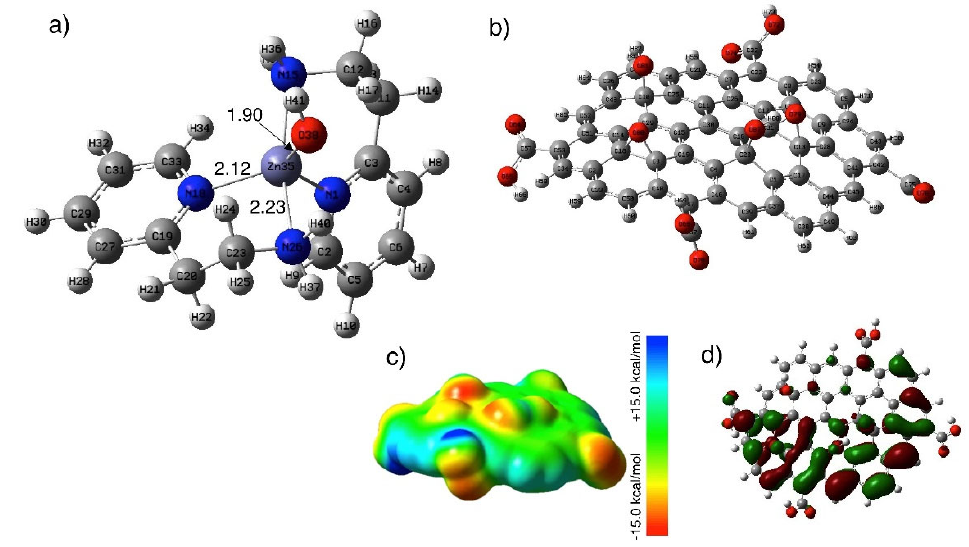
10 of 23 Figure 7. XRD patterns of GO, Zn3 and Zn3 /GO. 3.2. DFT Studies DFT calculations were performed using the B3LYP/6–311++G(d,p) level of theory to provide